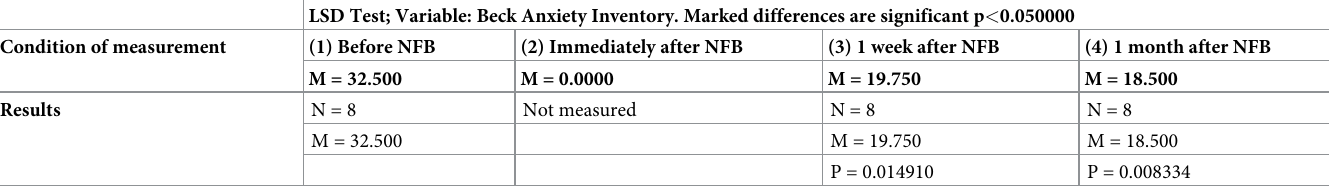
Table 2. Score for anxiety before and after NFB measured by Beck Anxiety